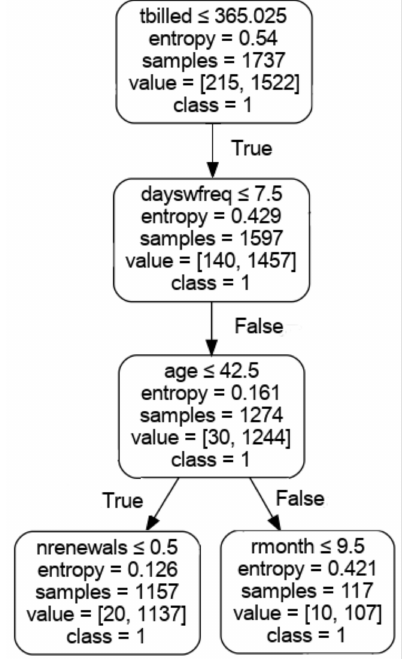
Figure 2. Example of a decision tree created using the DTC